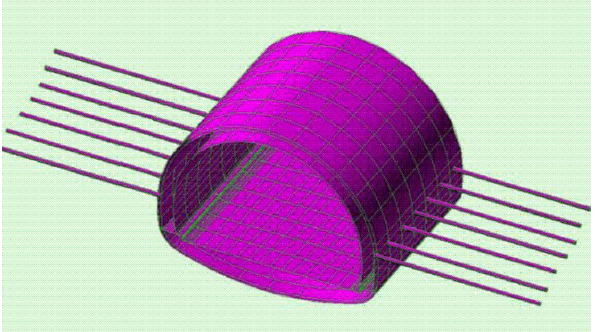
Figure 1. Schematic diagram of the composite cantilever support